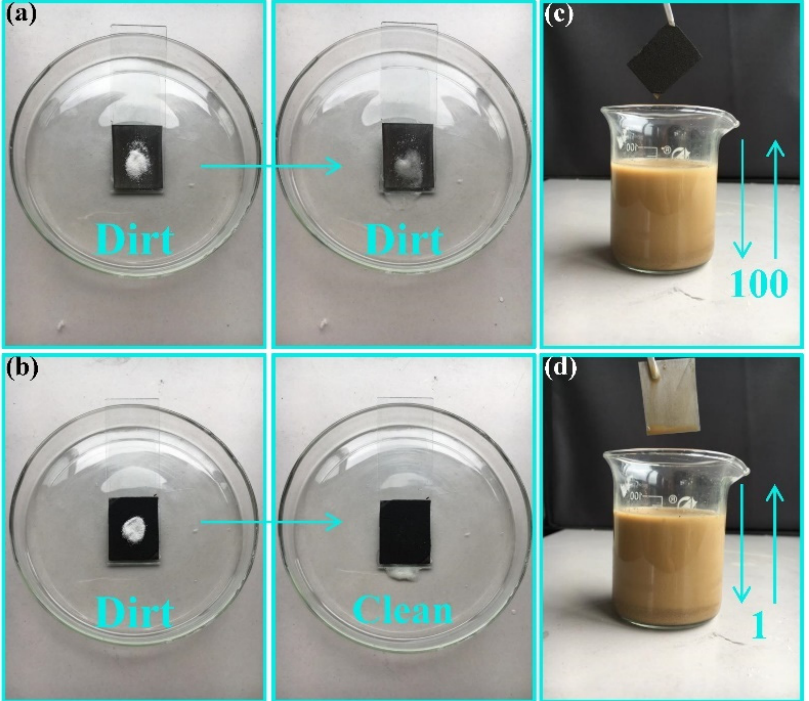
Figure 5. Self-cleaning property of the original sample ( a ) and CSC coating ( b ). Anti-fouling property of the CSC coating ( c ) and original sample ( d ).